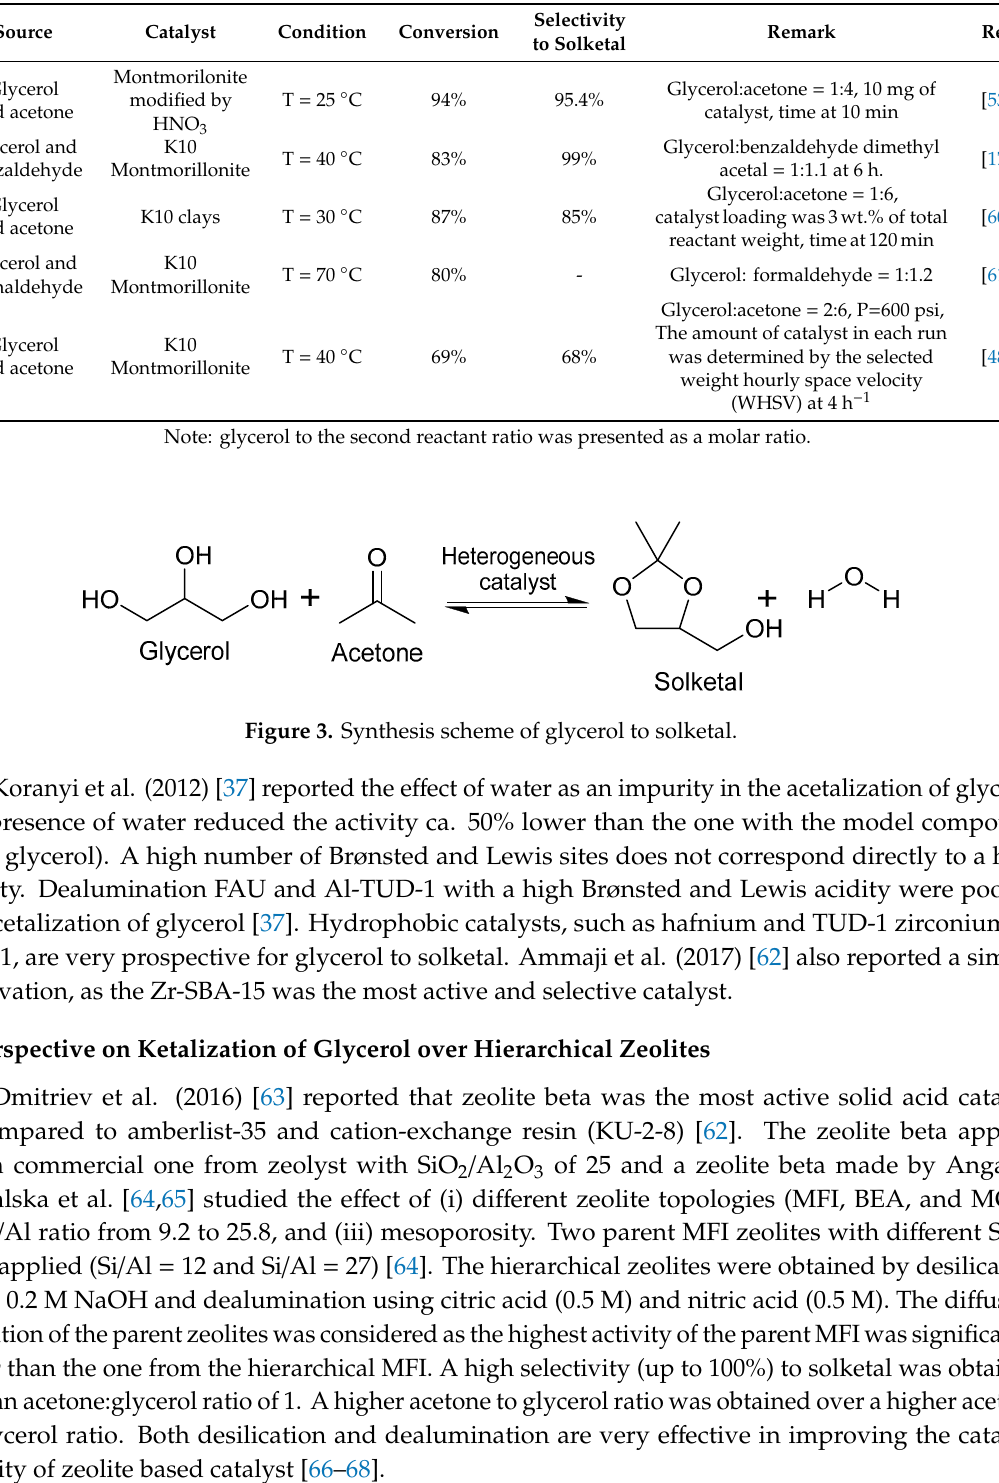
Table 5. Glycerol-to-solketal over clay minerals.